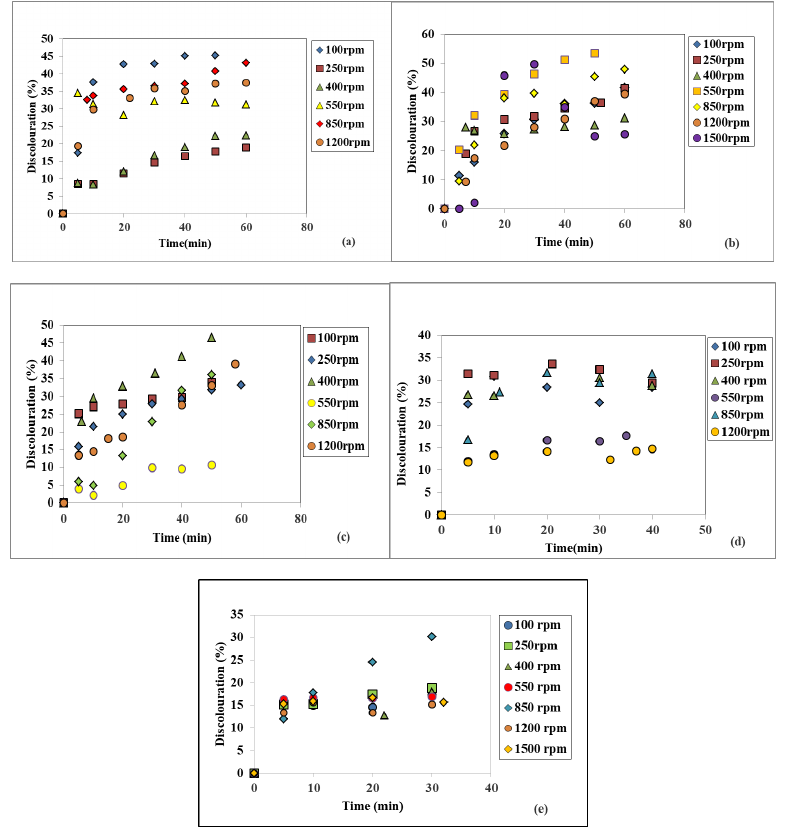
Figure 6. Influence of the disc rotational speed on discoloration at di ff erent WW flowrates: ( a ) 10 L / h, ( b ) 15 L / h, ( c ) 20 L / h, ( d ) 25 L / h, ( e ) 30 L /